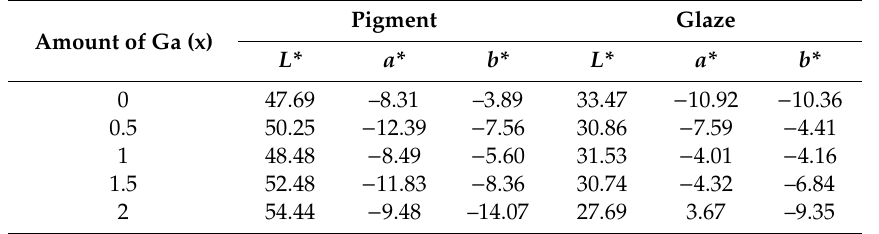
Table 3. CIELab colorimetric parameters of the CoCr 2 − x Ga x O 4 pigments, obtained at 1000 °C, and corresponding glazes.